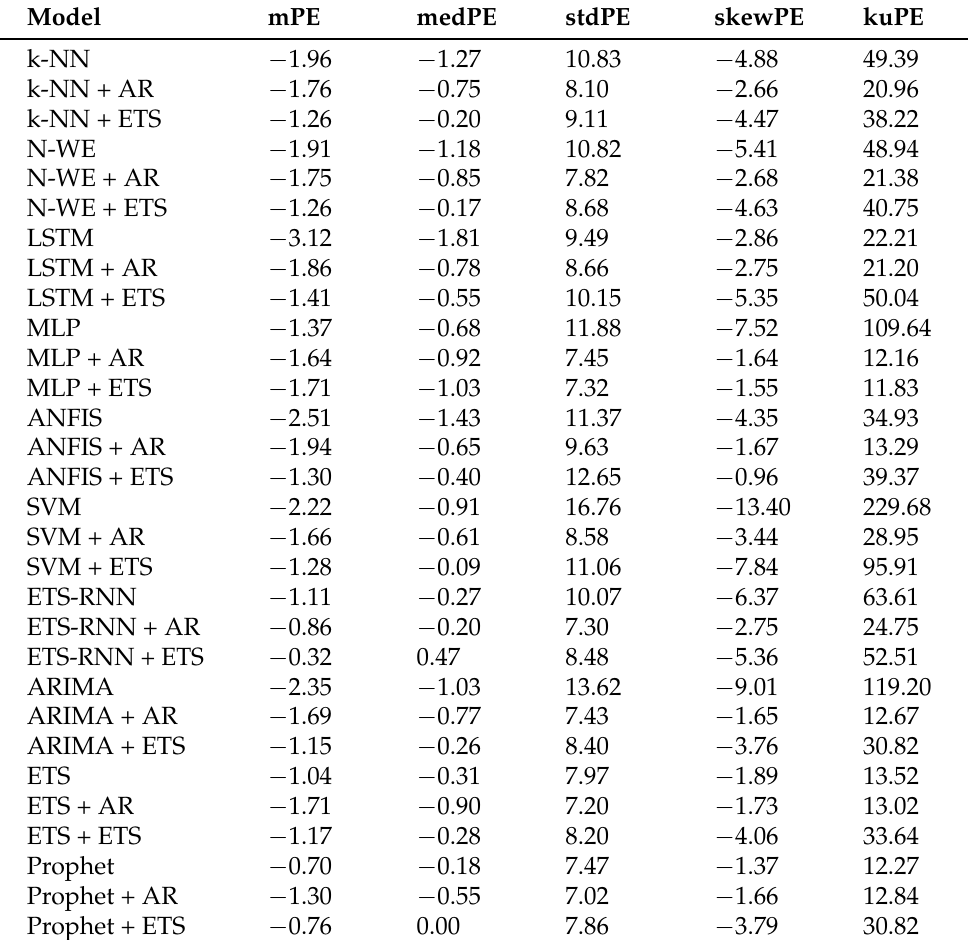
Table 3. Descriptive statistics of percentage errors among proposed and comparative